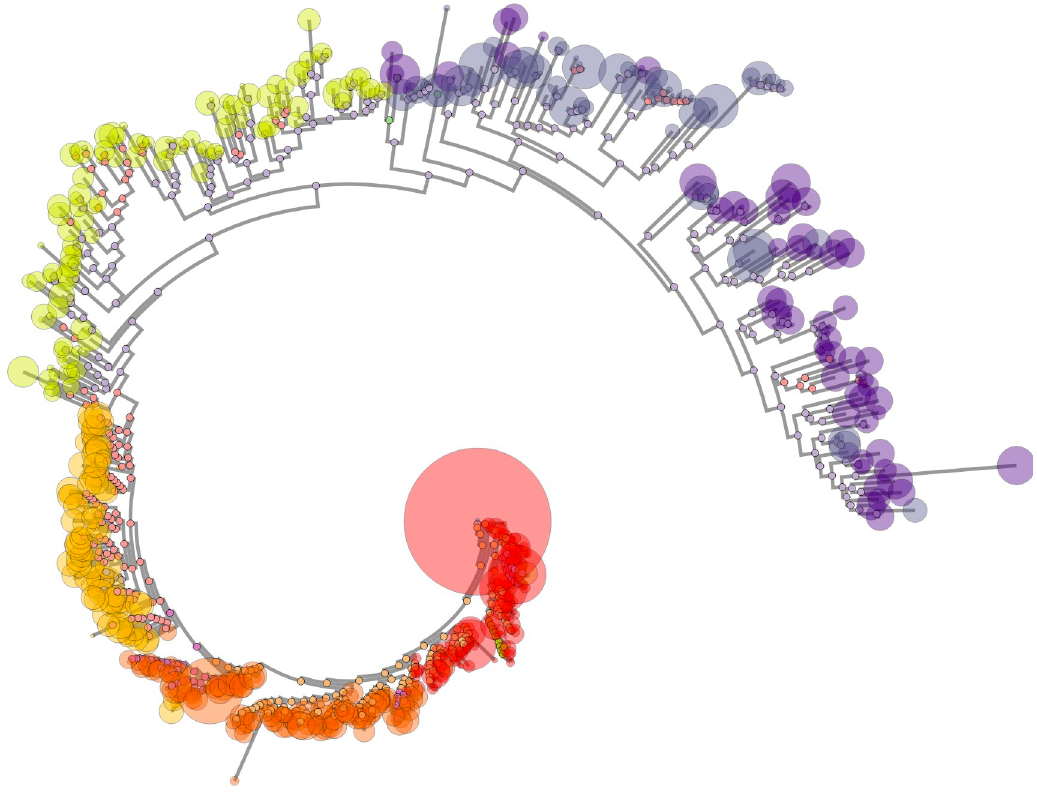
Fig 9. Screenshot of the phylogenetic tree viewer. Leaf node size corresponds to sequence copy number. Node color corresponds to time point. Since ancestral sequences have been inferred, ancestral nodes are colored according to the selected motif, which in this case is the N332 glycan